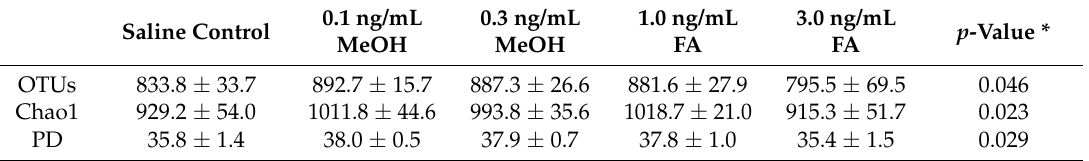
Table 1. Richness (Operational taxonomic units, OTU number, Chao1) and diversity (Phylogenetic Diversity, PD) values for fecal-associated bacteria in the formaldehyde (FA) or MeOH treated mouse